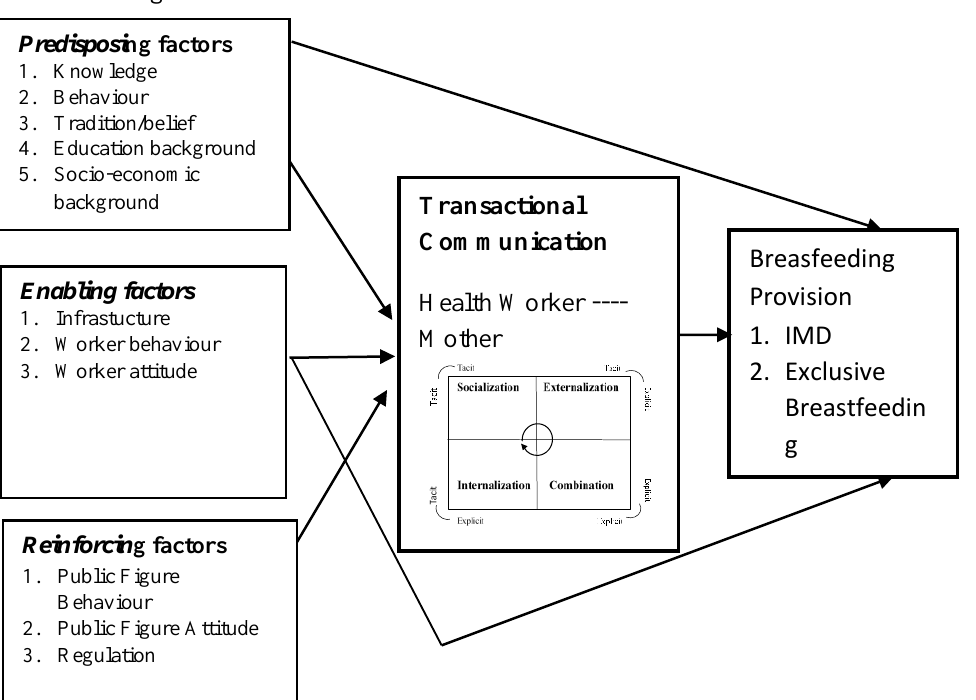
Figure 4. Research Finding of Transactional Communication Model between Midwife and Post- partum in providing exclusive